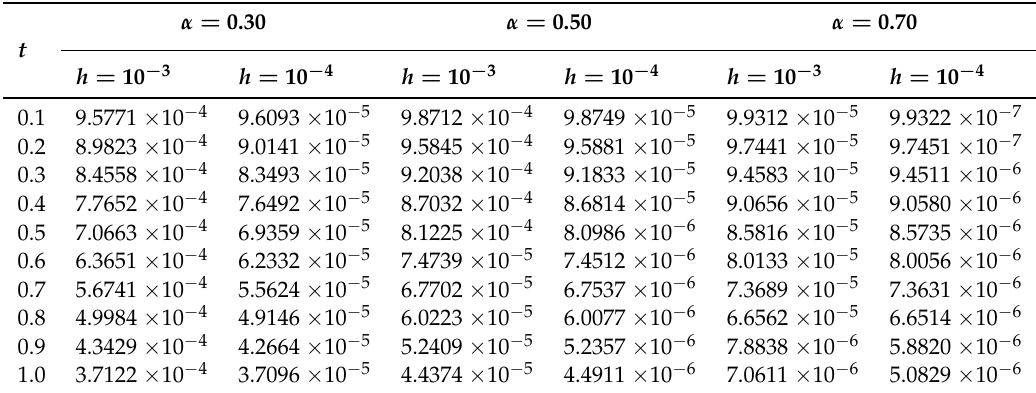
Table 1. Absolute error at each point, t when solving Example 1 using FEAM3 for different step size, h and 0 < α < 1.